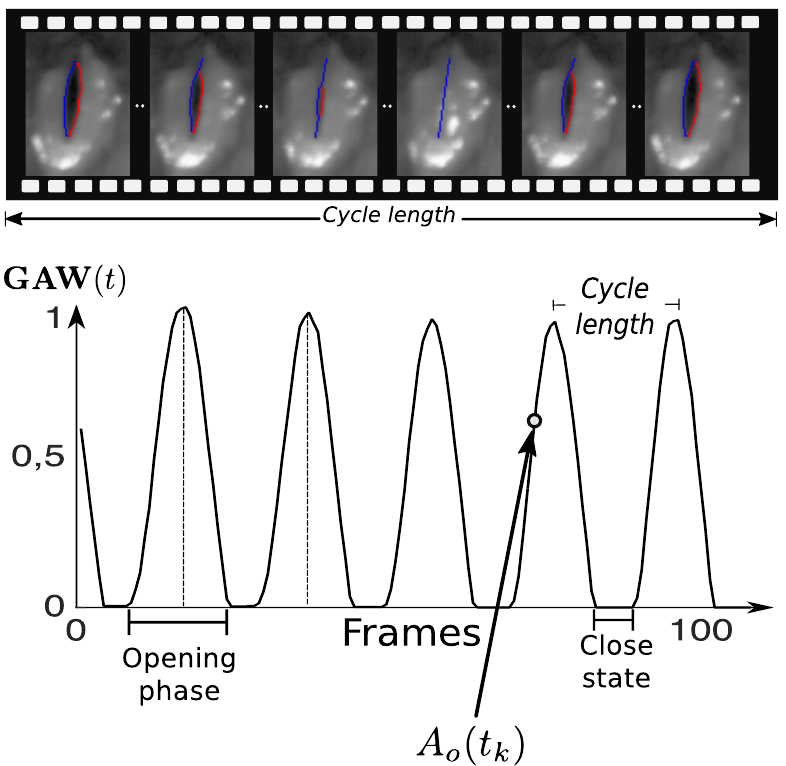
Figure 12. Illustration of the GAW playback. First row: six images of a particular glottal cycle length. Second row: GAW playback normalized within the interval [0,1] where 0 represents the minimum area and 1 the maximum